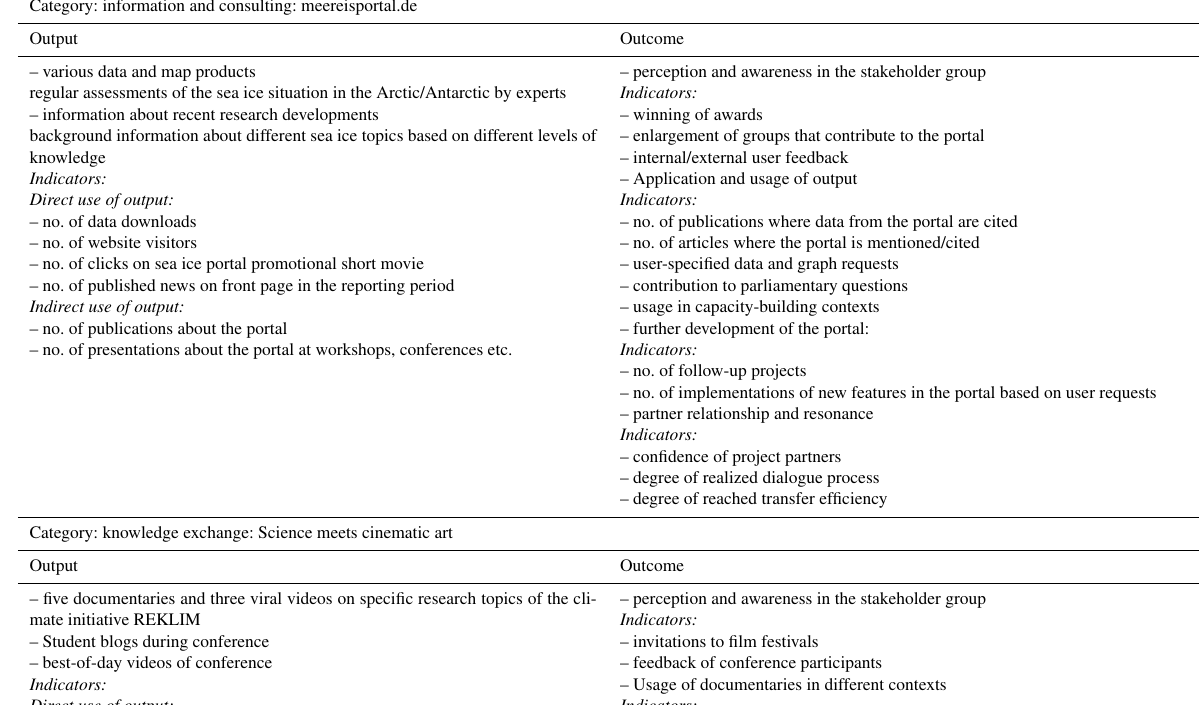
Table 3. Overview on derived indicators for three working examples divided into output and outcome. The process followed the “logical model